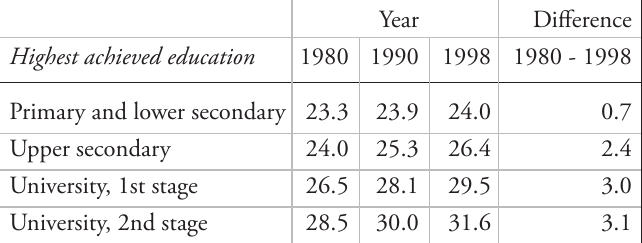
Table 1: Mean age at first birth among